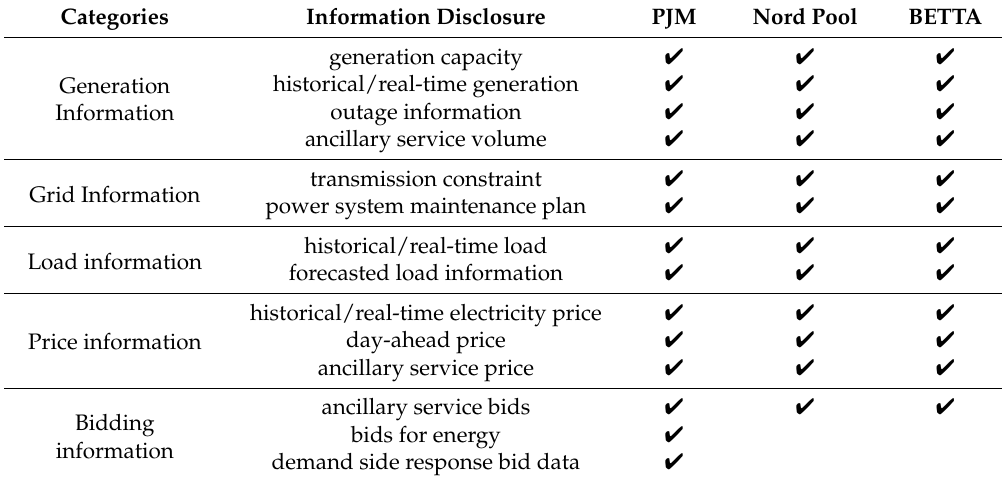
Table 6. Summary of information